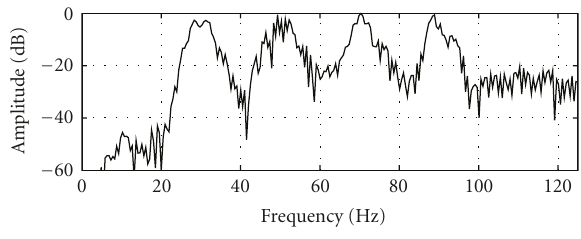
Figure 21: Result of the source spectrum estimation for source ULF-2 (to be compared with Figure